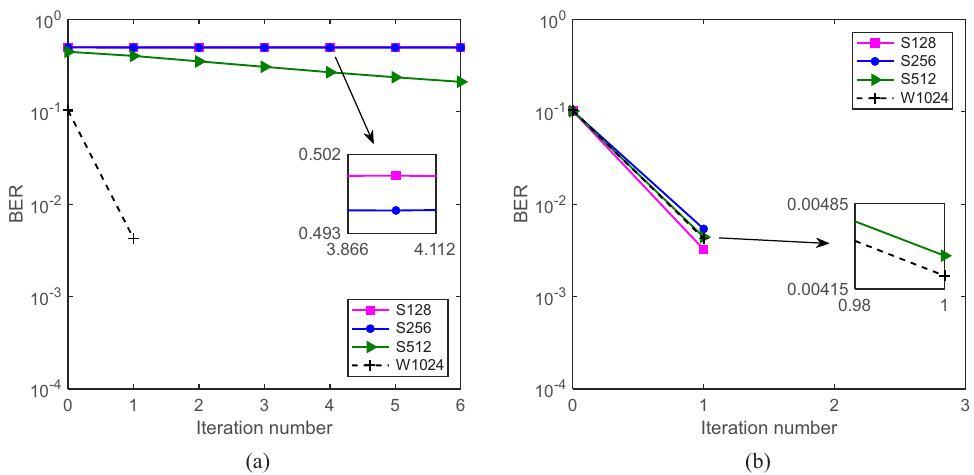
Figure 10. BER performance of the system with SNR = 13 dB, rate-1/2 convolutional code and the power ratio 0.25:1. ( a ) The GL algorithm is not used for channel estimation; ( b ) the GL algorithm is used for channel estimation.